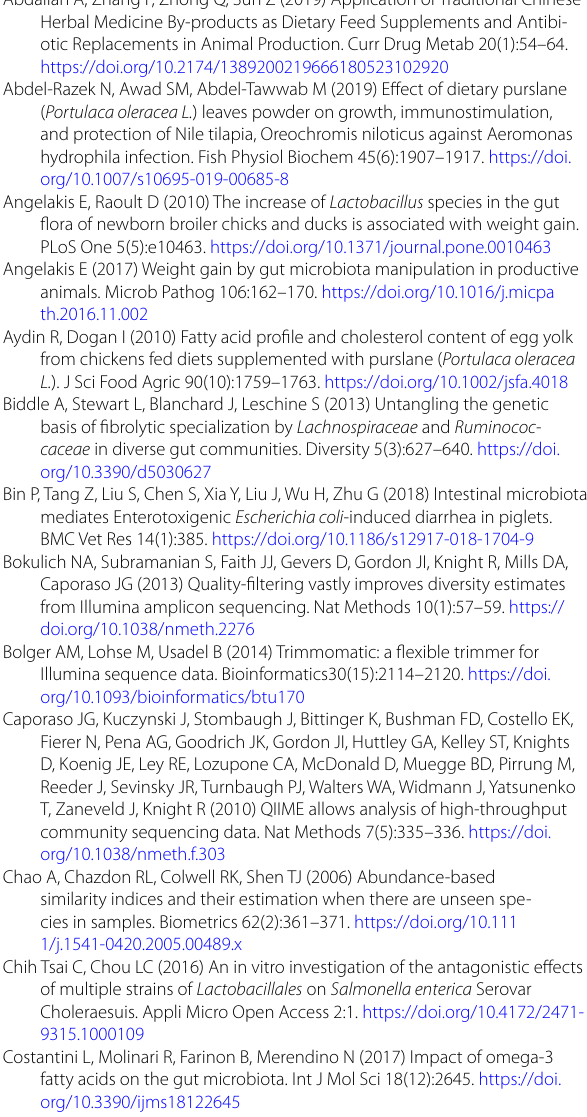
Additional file 1: Table S1. Composition and nutrient levels of basal diets for broilers. Table S2. Statistics of sample sequencing data processing result. Figure S1. Rarefaction curve and Shannon index curve drawn based on sequencing data. Additional file 2: Table S3. Predicted KEGG Pathways differentially abun- dant between four